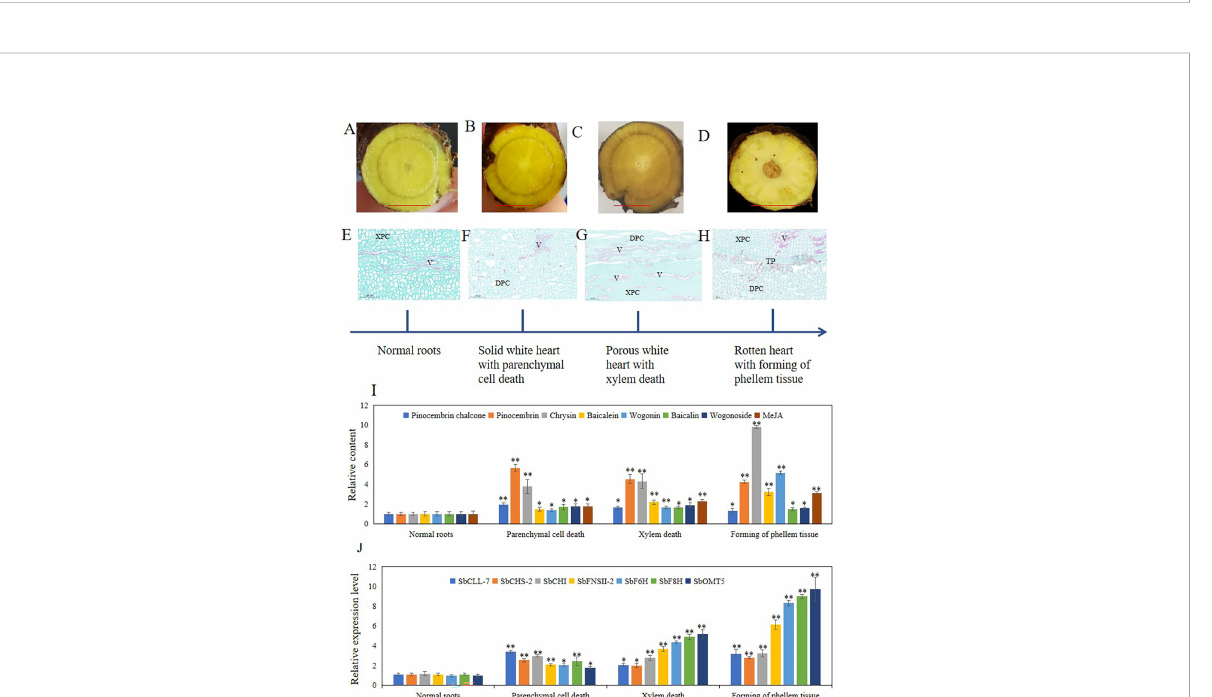
FIGURE 4 Four stages of hollowed roots development and relative content of metabolites related to 4 ’ -deoxy fl avones biosynthesis and relative expression level of genes related to 4 ’ -deoxy fl avones biosynthesis in each stage. (A-D) , cross section of roots in 4 stages, bar represent 1 cm. (E-H) , vertical section of roots in 4 stages. (I) , relative content of metabolites related to 4 ’ -deoxy fl avones biosynthesis, The data are the means ± SDs (n = 5). (J) , relative expression level of genes related to 4'-deoxy fl avones biosynthesis, The data are the means ± SDs (n = 3). *means p < 0.05, **means p < 0.01. XPC, xylem parenchyma cells. V, vessels. TP, ternary phellem. DPC, dead parenchyma